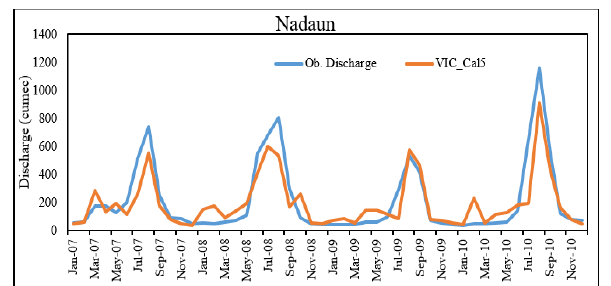
Figure 7 Plot of simulated and observed discharge at Nadaun during calibration period.